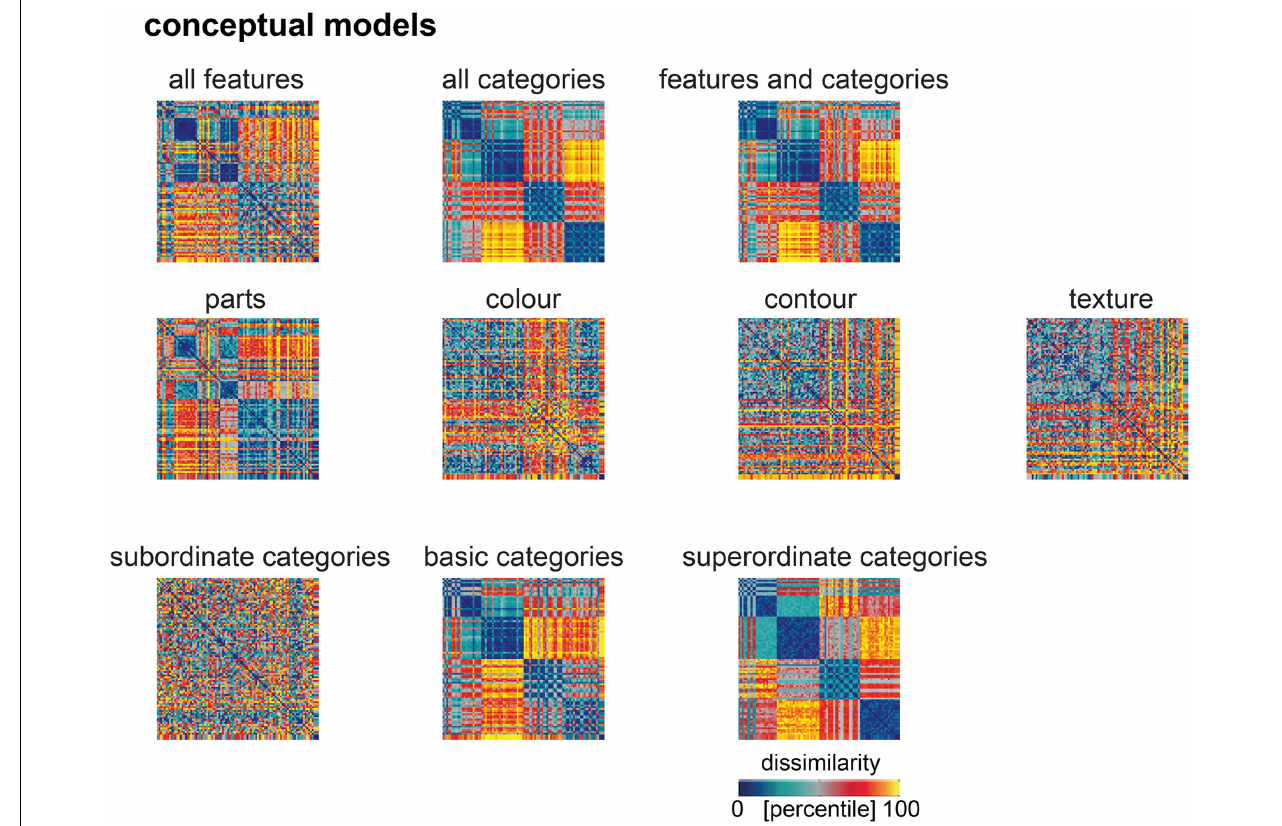
FIGURE 7 | Model predictions of the similarity judgments for each conceptual model. RDMs for each conceptual model, after weighting the single-feature and single-category RDM models to best predict the human similarity judgments. We used a total of 10 conceptual models, derived from labels describing the 92 object images, which were generated by human observers. From the visual-feature descriptions, we constructed four feature-based RDMs, capturing object dissimilarity in terms of object parts, color, contour and texture. From the category labels, we constructed three separate categorical RDMs, capturing object dissimilarity in terms of subordinate, basic or superordinate categories. We also constructed comprehensive feature-based and categorical RDMs, by weighting all single-feature and all single-category RDMs, respectively, to best predict the similarity judgements, and a combined model, by weighting all single-feature and single-category RDMs models together to best predict the similarity judgements. Values within each RDM were transformed into percentiles for visualization (see color